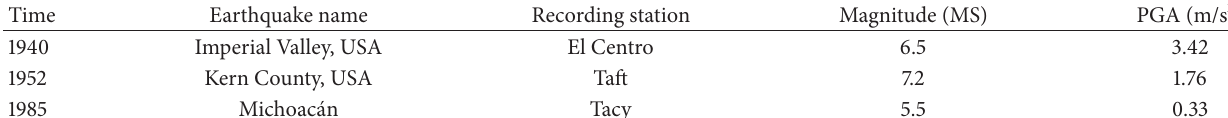
Table 2: The ground motions used in this study.